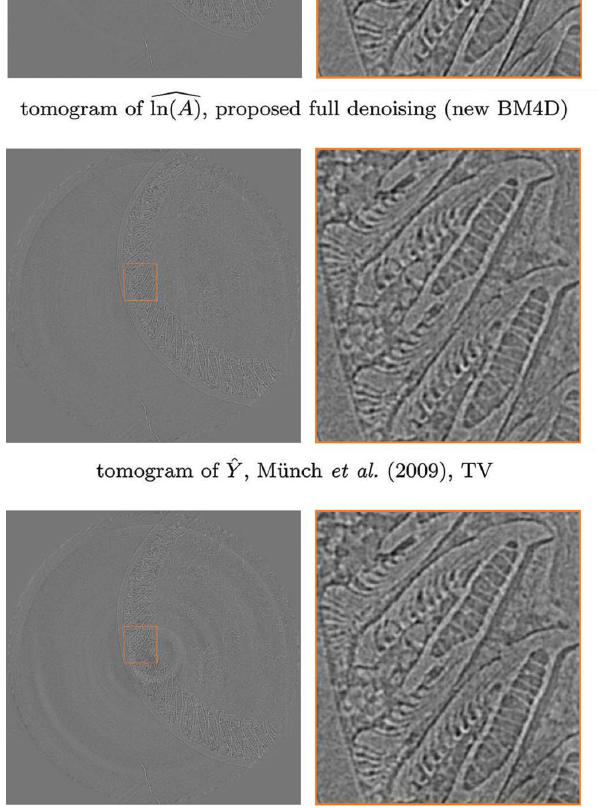
Figure 11 Comparison of fully denoised tomograms of 00072, corresponding to the sinogram in Fig. 9. Top-to-bottom: tomogram reconstructed from a noisy sinogram of the stack of projections Z (4), of the estimate of stack of underlying projections d ln ð A Þ ln ð A Þ with the proposed procedure with FBP reconstruction, and tomograms of the estimates for streak-free stacks ^ YY of Mu¨nch et al. (2009) with TV reconstruction, and ^ YY of Vo et al. (2018) with TV reconstruction. TV regularization was tuned visually, balancing residual noise and smoothing of signal. Compared with the reference methods, the proposed procedure manages to remove most streaks without significant loss of detail, as well as most Poissonian noise without excess smoothing of the